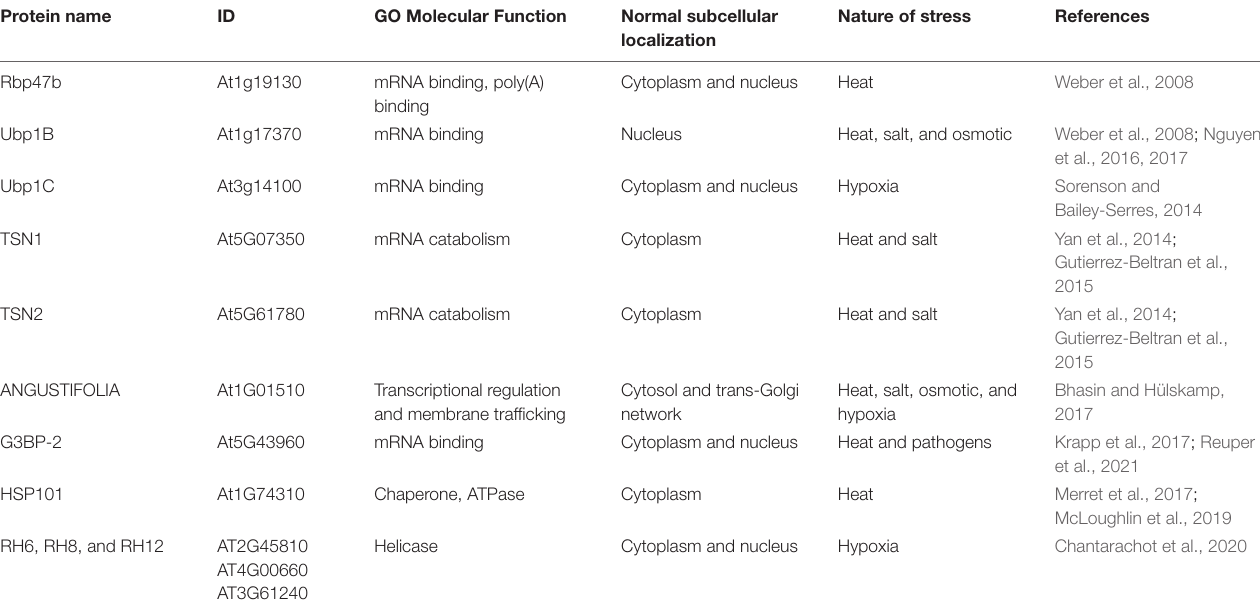
TABLE 1 | Stress granule (SG) formation and stress